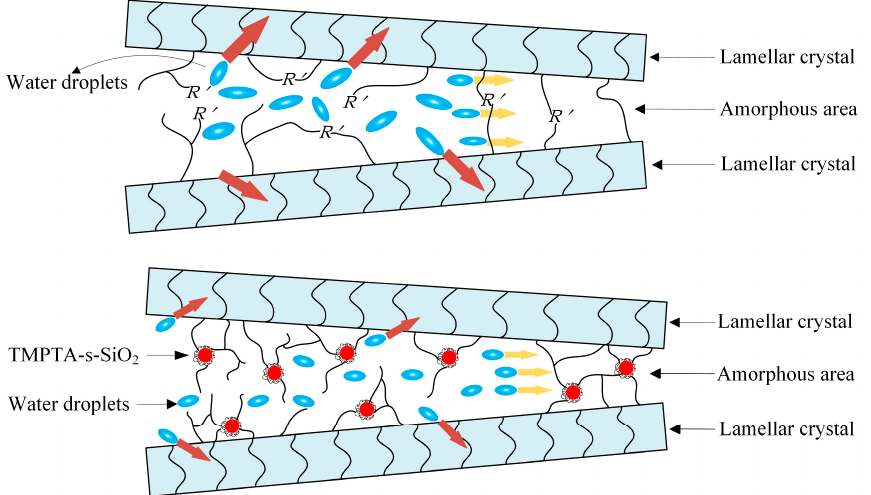
Figure 8. Schematic mechanism of water micro-beads impacting on amorphous regions under AC electric field in XLPE ( top panel ) and TMPTA-s-SiO 2 /XLPE nanocomposite ( bottom panel ).